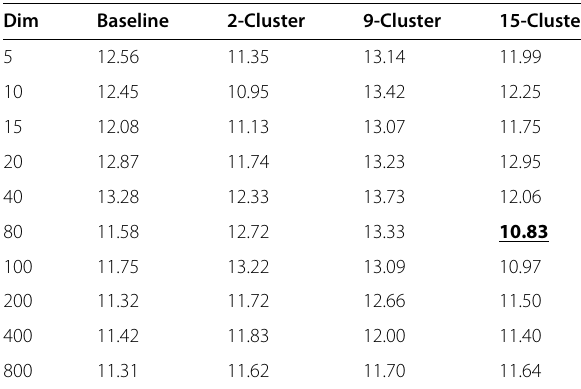
Table 4 Regression results with feature selection using the clustering approach with 2, 9, and 15 clusters. Turkish database is used. Statistically significant ( p < 0.05 ) improvement is shown